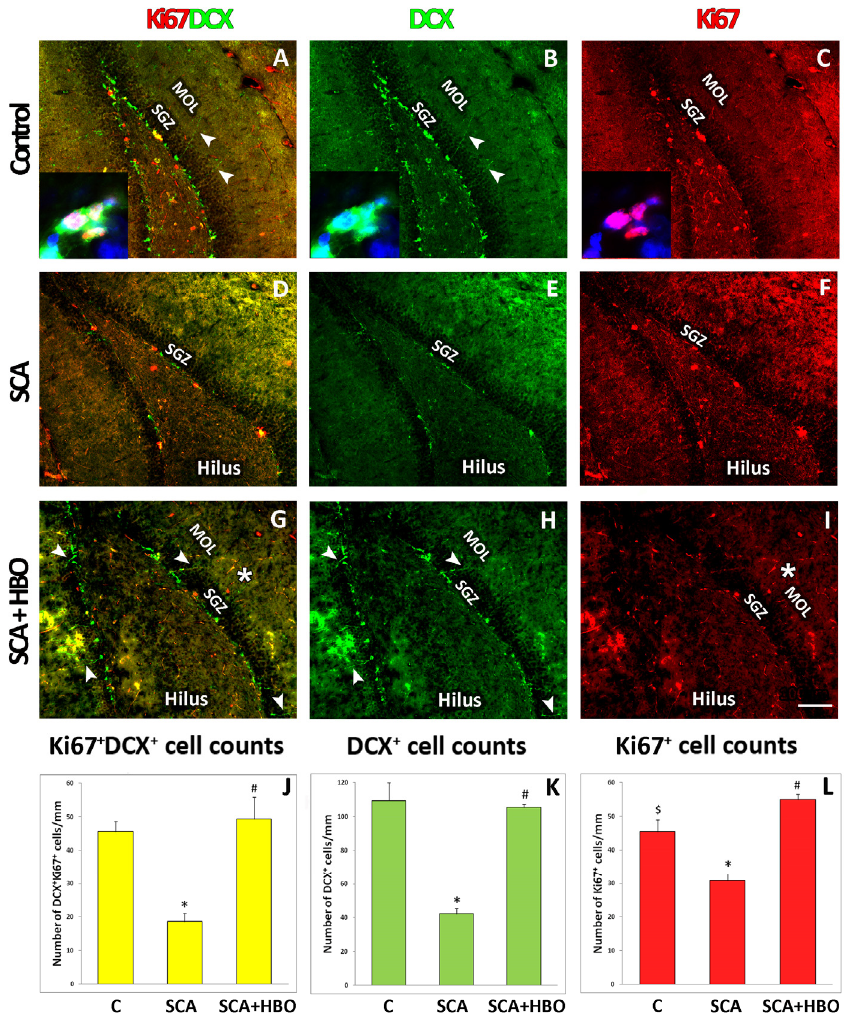
Figure 6. Effect of SCA (suction cortical ablation) and HBOT (hyperbaric oxygen therapy) on cell proliferation in the hippocampal DG (dentate gyrus). The proliferation marker Ki67 was used to quantify the number of dividing cells (red fluorescence), while DCX (a marker of immature neurons, green fluorescence) was used to identify cells of neuronal lineage. The higher magnification images of control sections were counterstained with DAPI (blue) to visualize cell nuclei. ( A – C , inset) The Ki67 signal was restricted to the nuclei of cells (red fluorescence, A , C insert). In contrast, ( A , B , inset), the DCX signal was mainly located in the cell cytosol (green fluorescence) and the cellular processes arising from the SGZ (subgranular zone) until the MOL (molecular cell layer) (green fluorescence, A , B , arrowheads). SCA reduced Ki67+/DCX+ ( D , yellow fluorescence), DCX+ ( E , green fluores ‐ cence), and Ki67+ ( F , red fluorescence) immunoreactivity in SGZ. In contrast, HBOT increased the number of DCX+ neurons with processes extending until the MOL ( G , H arrowheads) and increased Ki67 cells in SGZ, hilus, and MOL ( I , red fluorescence, asterisk). C—Control, SCA—Suction cortical ablation, SCA + HBO—SCA animals treated with hyperbaric oxygen. ( J – L ) Cells that were Ki67+/DCX+ (yellow fluorescence), DCX+ (green fluorescence), and Ki67+ (red fluorescence) were counted along the entire SGZ of the DG. While the number of all counted cells was drastically re ‐ duced after SCA, following HBOT, the number of proliferating immature neurons was at the same level as observed in the controls. In contrast, the overall proliferation of all Ki67 ‐ positive cells in ‐ creased. Bars represent mean ± SD. The level of significance was analyzed using One ‐ way ANOVA with Tukey’s multiple comparisons post hoc test (* p < 0.001 SCA vs. C, $ p < 0.001 SCA + HBO vs. C, # p < 0.001 SCA + HBO vs. SCA). Scale bar 50 μ m ( A – I ).